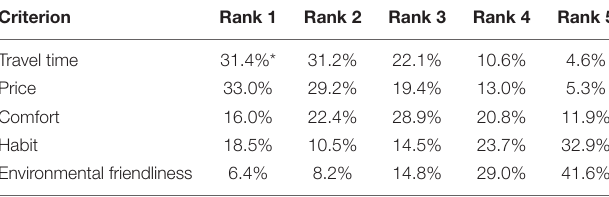
TABLE 2 | Socio-demographic characteristics of sample and population. TABLE 4 | Criteria for choice of transport means between 100 and 500